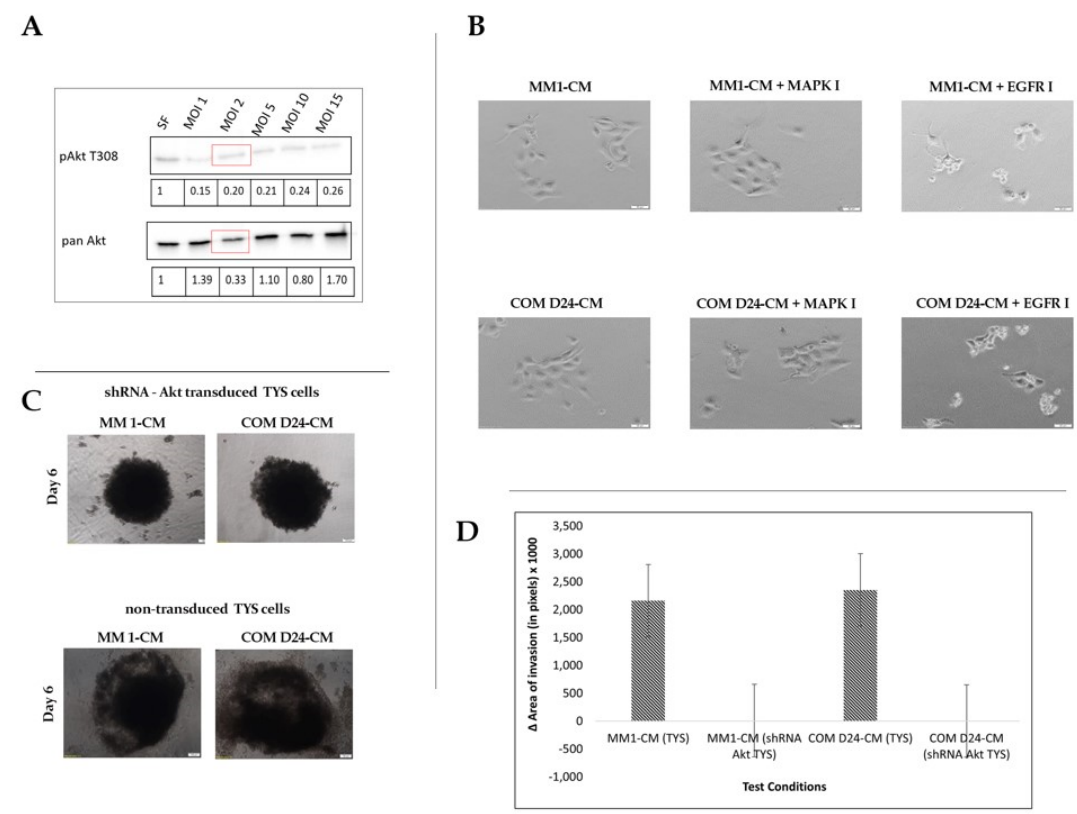
Figure 5. Scattering and invasion of Akt-silenced TYS cells. ( A ) Akt expression and activation after silencing the Akt gene using differentmultiplicity of infection (MOI) of shRNA lentivirus. MOI 2 (red box) was chosen for transfection. Akt-silenced TYS cells were called shRNA Akt TYS. ( B ) Scattering of shRNA Akt TYS cells in response to fibroblast conditioned medium. shRNA Akt TYS cells were not stimulated to scatter in response to fibroblast CM and did not survive when treated with EGFR inhibitor after 48 h. Scale bar = 50 µ m ( C ) Invasion of shRNA Akt TYS cells from the spheroids into the collagen matrix in response to fibroblast CM. Images were captured using an inverted microscope (Olympus) and processed with CellSense 2.0 imaging software (Olympus). Scale bar = 100 µ m ( D ) Graphical presentation of Akt-silenced Akt TYS invasion and shRNA Akt TYS cells were not stimulated to invade in response to fibroblast